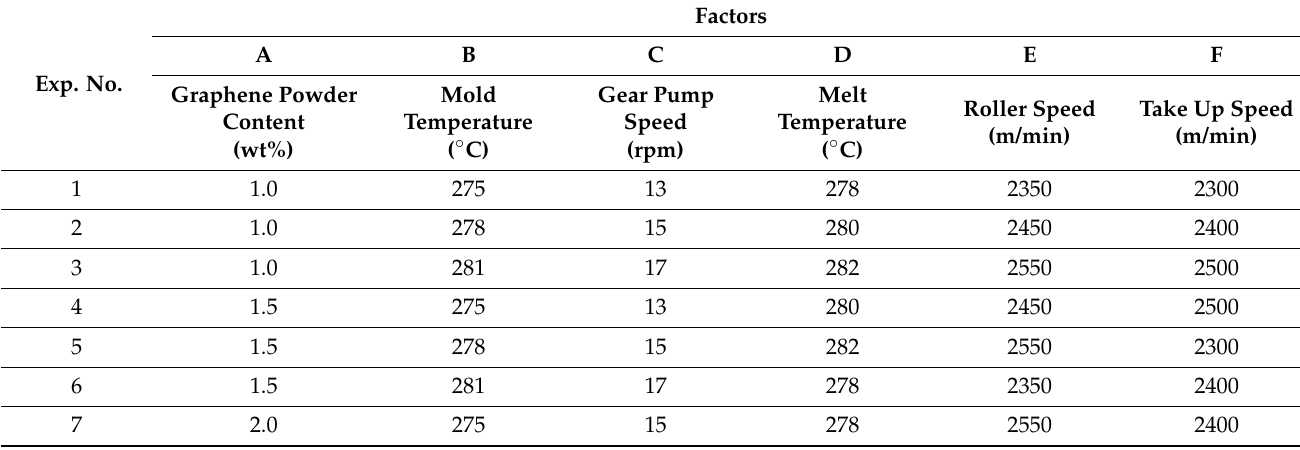
Table 2. Optimization experiment plan of graphene-modified polyester